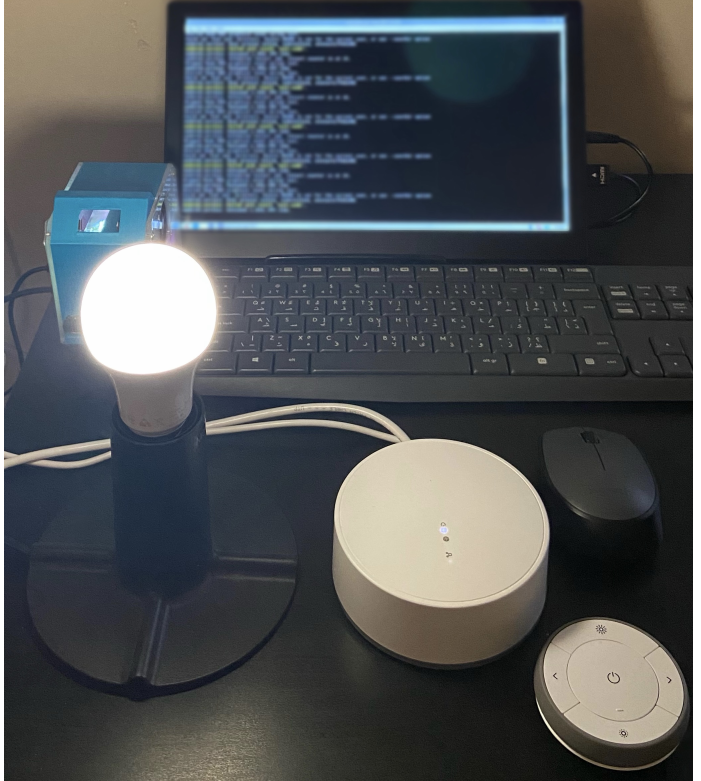
Figure 3. Photo of experimental setup showing Rasberry Pi, Smart Bulb, TRÅDFRI Gateway, and Remote